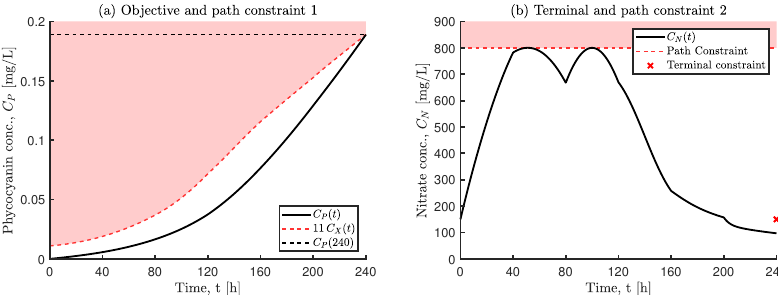
Figure 12. Semi-batch reactor plant optimum conditions.